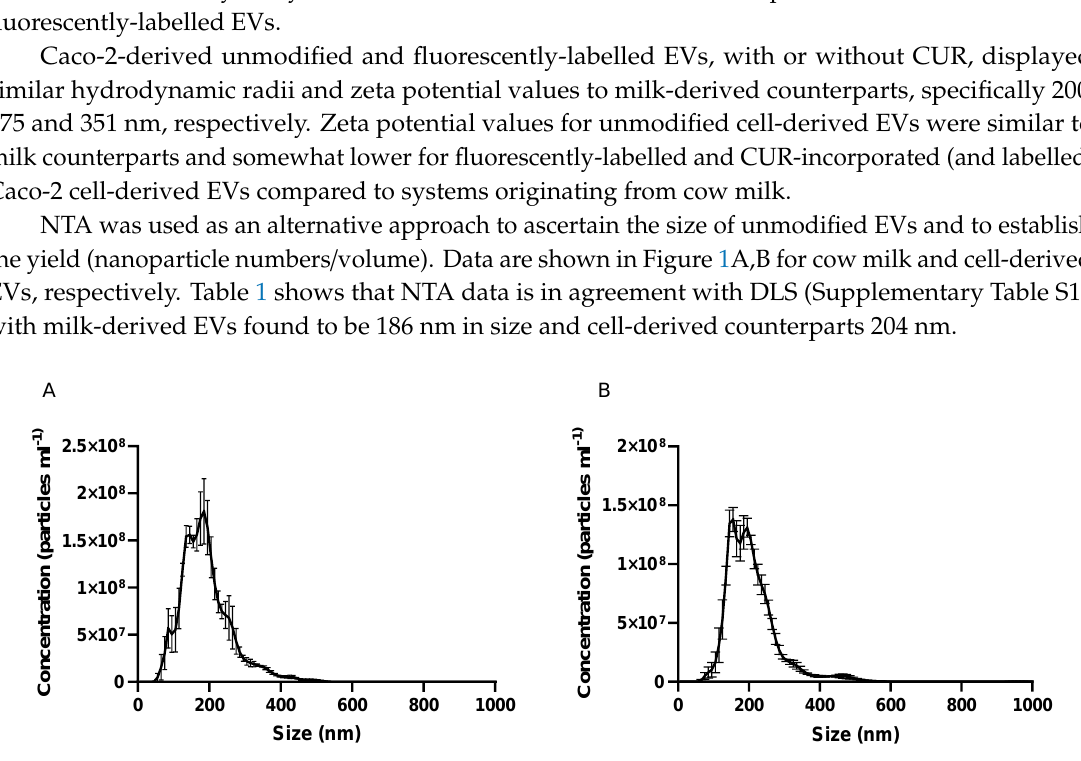
Figure 1. Nanoparticle tracking analysis (NTA) graphs of ( A ) cow milk extracellular vesicles and ( B ) Caco-2 cell-derived extracellular vesicles. Data are shown as mean +/ − SD ( n = 3). Table 1. Size (nm), yield (particles/mL) and protein concentration (µg/mL) of Caco-2 extracellular vesicles and milk extracellular vesicles, as measured using nanoparticle tracking analysis instrument (data expressed as mean +/-SD; n = 3). Protein concentration measured using the Bicinchoninic acid (BCA) assay.